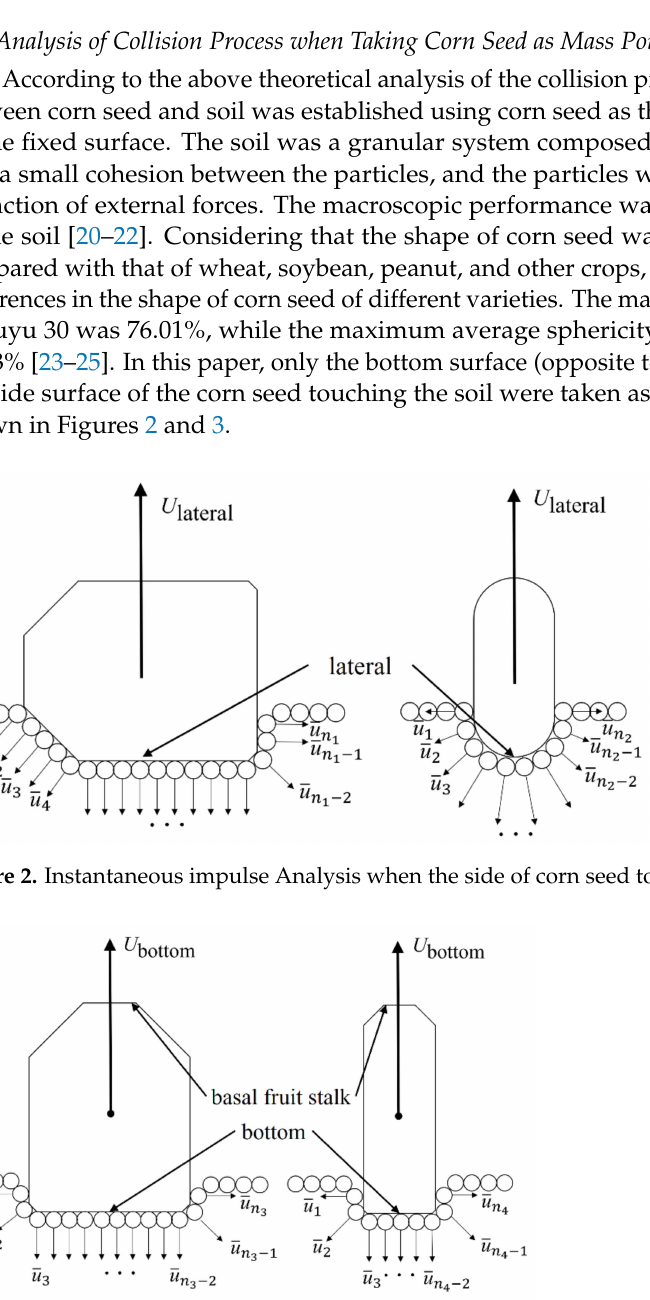
Figure 3. Instantaneous impulse Analysis when the bottom of corn seed touches